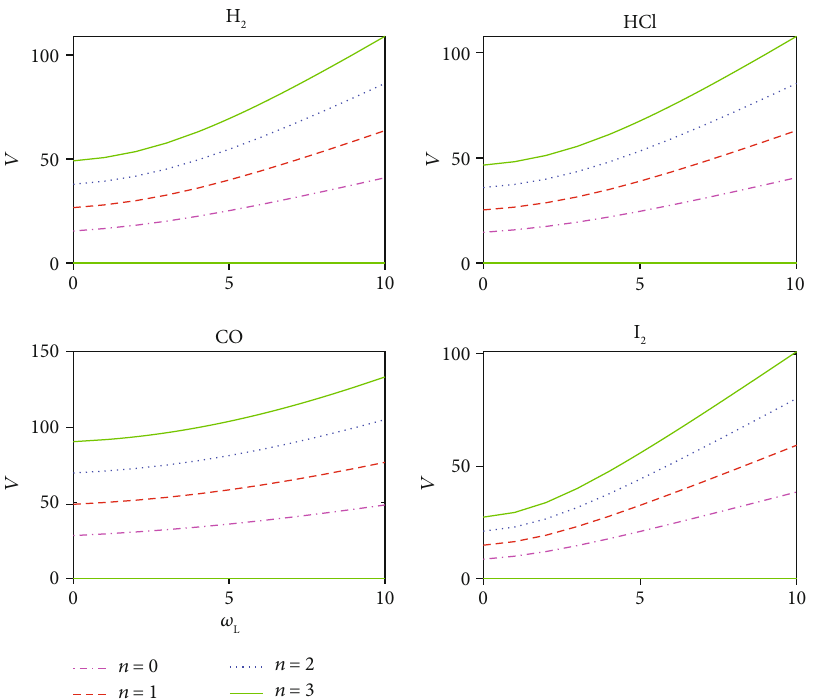
Figure 4: The expectation value of potential energy V as a function of Larmor frequencies ω for various numbers of states n with g = m = 1